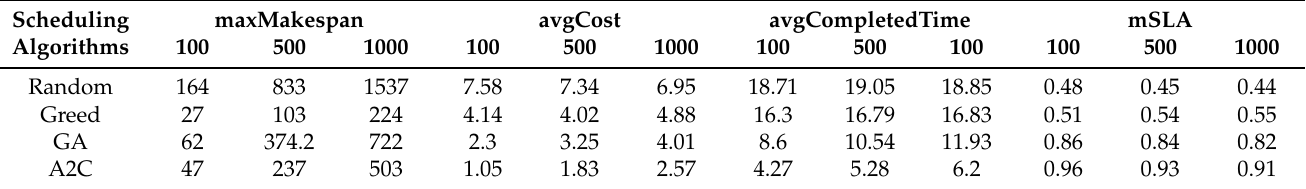
Table 4. The performance of the four scheduling algorithms on each metric. The columns give the results of the algorithms on the different evaluation metrics and the rows indicate the different scheduling algorithms. Each metric is further divided into results on sets of 100, 500, and 1000 number of